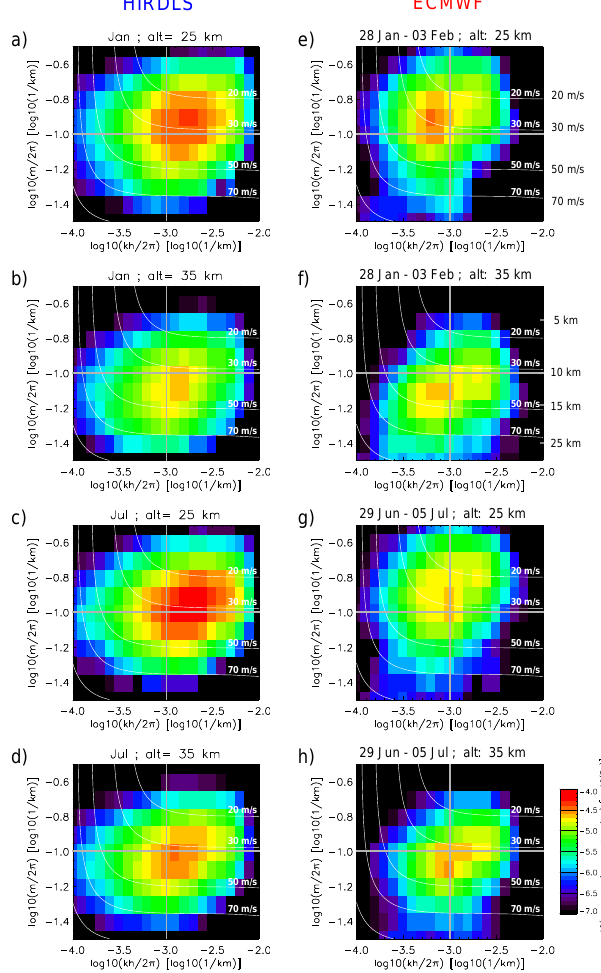
Figure 8. Spectra of GWMF normalized to the total number of all wave events ([log10 over 1Pa]; black, 10 − 4 mPa to red, 0.1mPa) Fig.8. SpectraofGWMFnormalizedtothetotalnumberofallwaveevents([log10over1 Pa ];black,10 − 4 mPa vs. horizontal and vertical wave number (both [log10 of km − 1 ]). to red, 0.1mPa) vs. horizontal and vertical wavenumber (both [log10 of km − 1 ]). Due to observational effects, Due to observational effects, spectra from HIRDLS (left column) spectra from HIRDLS (left column) are long-biased compared to the true distributions in terms of horizontal are long-biased compared to the true distributions in terms of hor- wavelength, but still peak at much shorter horizontal wavelengths than spectra from ECMWF (right column). izontal wavelength, but still peak at much shorter horizontal wave- For better orientation, the gray grid-lines indicate 10 km vertical wavelength and 1000 km horizontal wave- lengths than spectra from ECMWF (right column). For better ori- length, respectively. White lines give intrinsic phase speed (labels are reproduced at the right y-axis of (e) ). 45 entation, the gray grid-lines indicate 10km vertical wavelength and Vertical wavelength values are given at the right y-axis of (f) . 1000km horizontal wavelength, respectively. White lines give in- trinsic phase speed (labels are reproduced at the right y axis of (e) ). Vertical wavelength values are given at the right y axis of (f) .